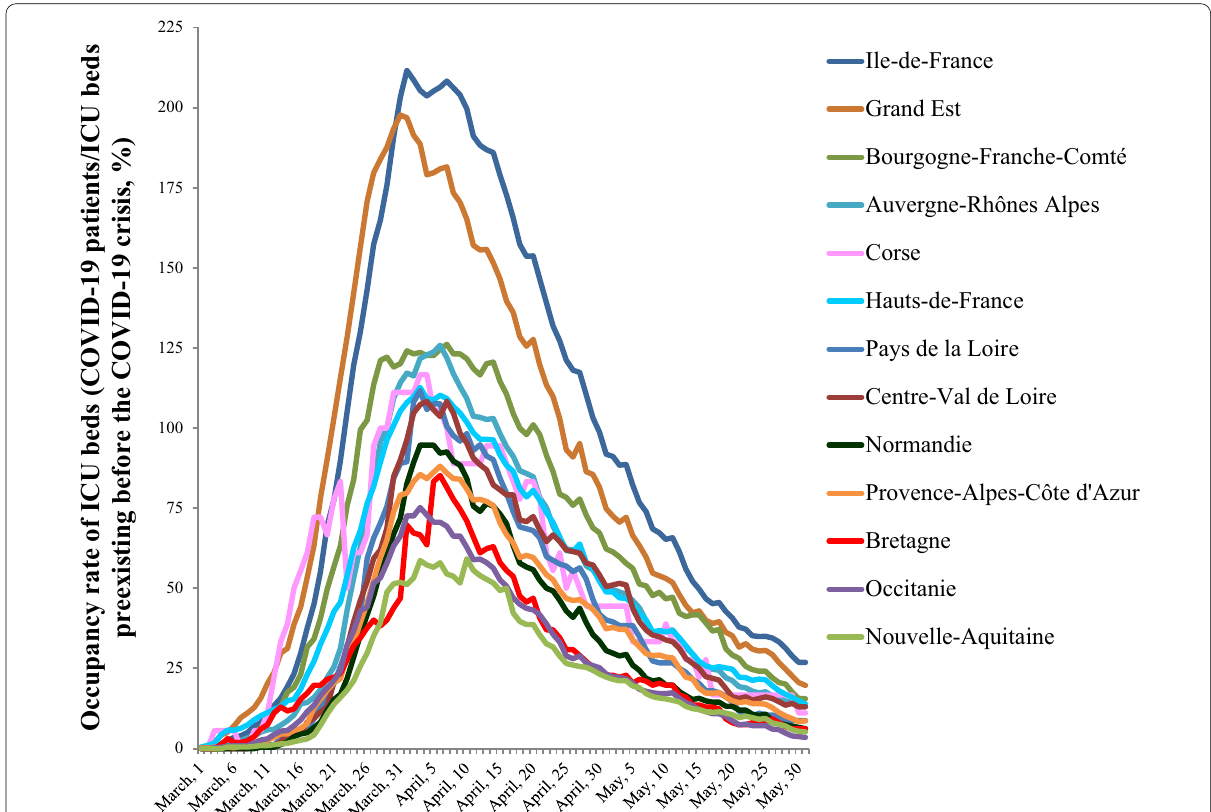
Fig. 1 Evolution of occupancy rate of ICU beds by COVID‑19 patients, according to the French administrative region. The number of beds refers to ICU beds pre‑existing before the COVID‑19 crisis